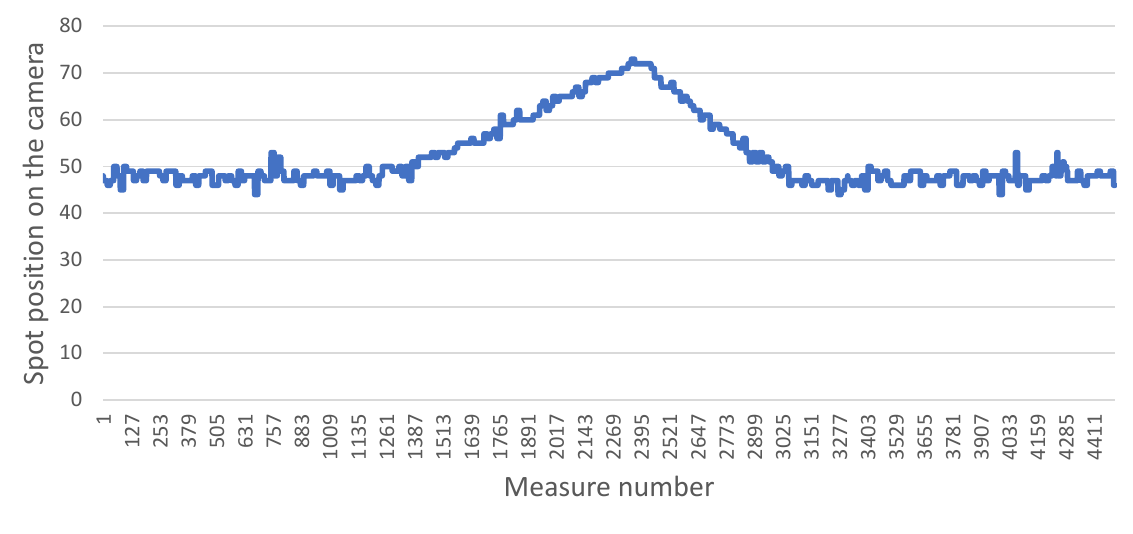
Figure 12. Evolution of position measured while the wheelchair moves toward a downward slope and then on flat ground.